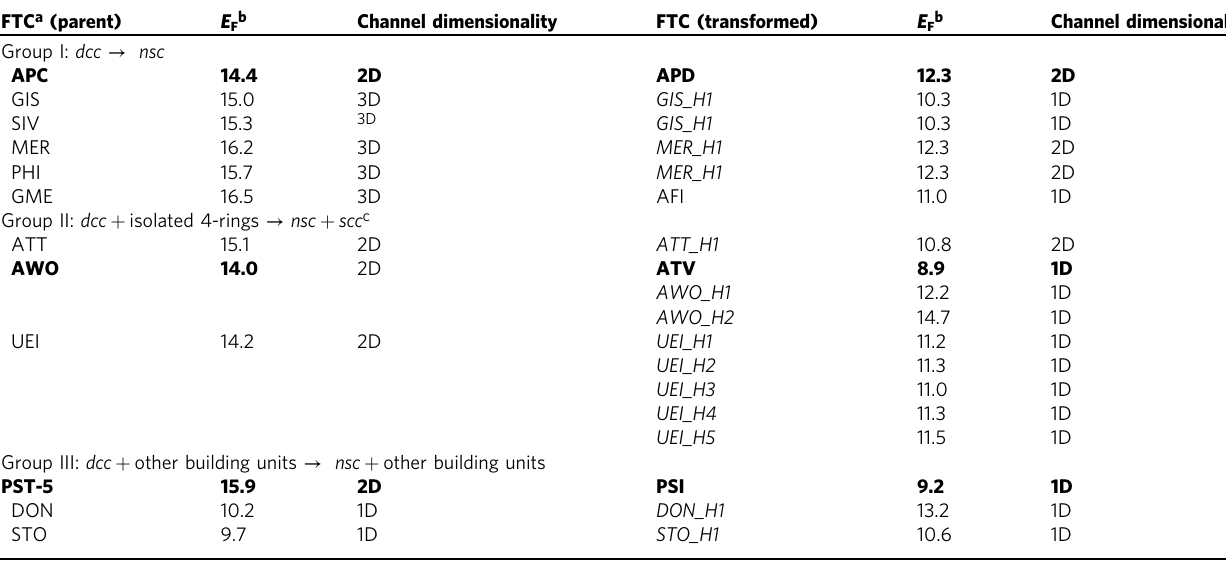
Table 1 Observed (in bold) and predicted 3D – 3D topotactic transformations of zeolites through chain transformation from dcc to nsc and d 4 r to nsc